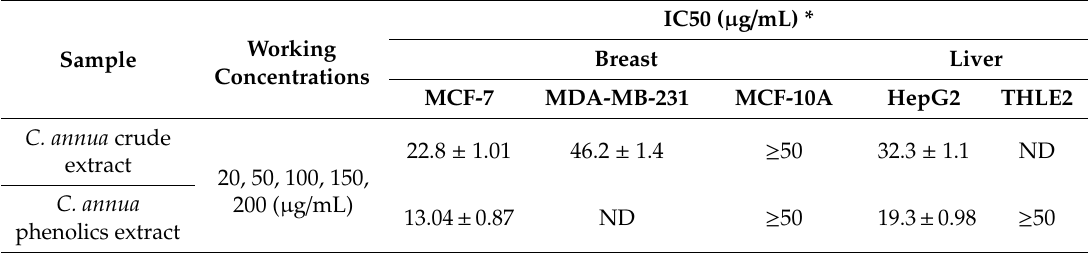
Table 3. IC 50 values of both C. annua crude and phenolics extracts against panel of breast and liver cancer and normal cells using the MTT